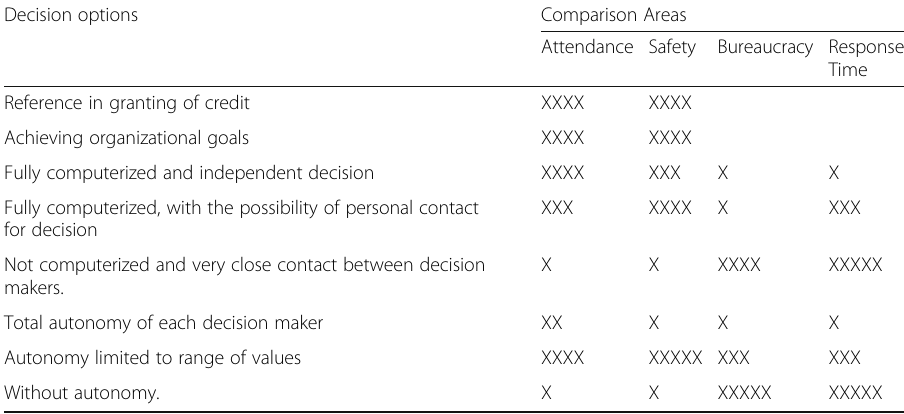
Table 4 Score for decision areas